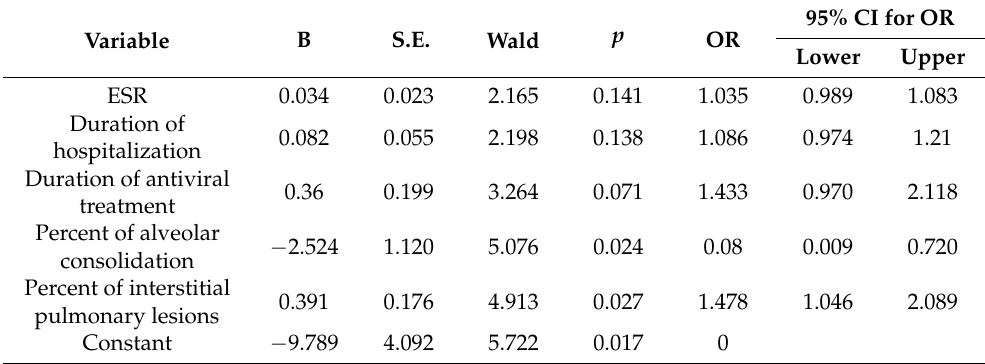
Figure 2. Receiver operating characteristics (ROC) curve for the ability of the “percent of interstitial pulmonary lesions” to predict pulmonary fibrosis. The area under curve (AUC) = 0.827 (0.736–0.918 CI 95%). Table 5. Multivariable logistic regression model for patients with lung